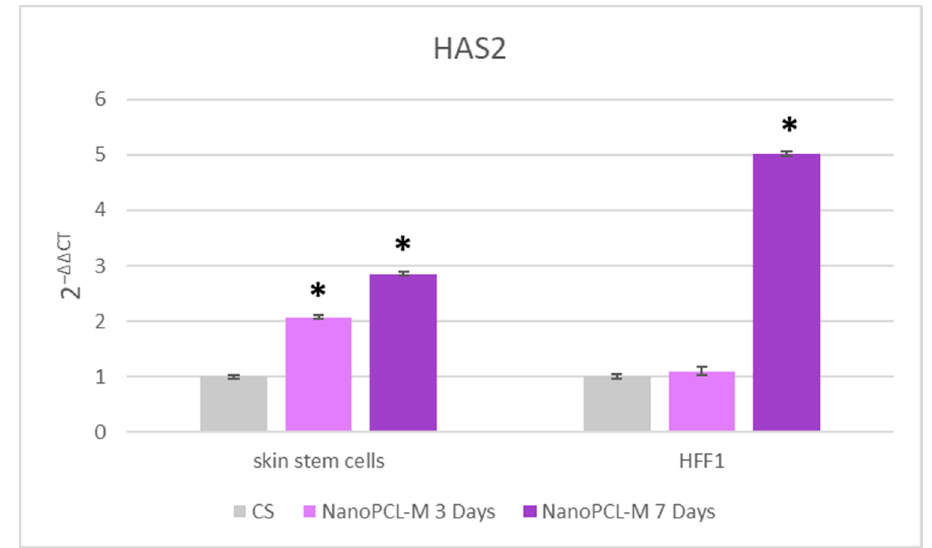
Figure 8. Effect of NanoPCL-M pretreatment on the expression of HAS2. Skin stem cells and HFF1 exposed (T) or not (CS) to three to seven days of NanoPCL-M pretreatment were stressed by UV light. The amount of mRNA from NanoPCL-M treated cells was normalized to HPRT1 and was plotted as fold change (2 −∆∆ CT ) relative to the mRNA expression of UV stress control (CS). * p value ≤ 0.05